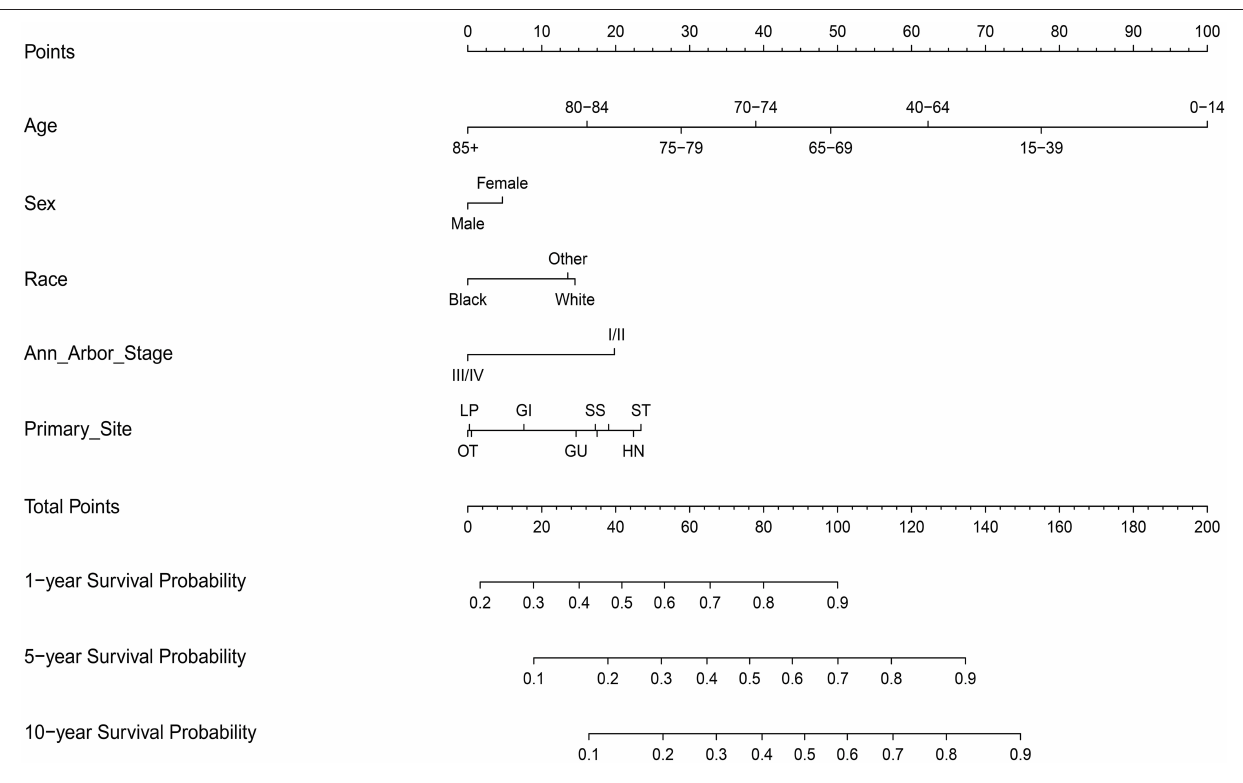
FIGURE 8 | Nomograms of patients with extranodal DLBCL for predicting overall survival.